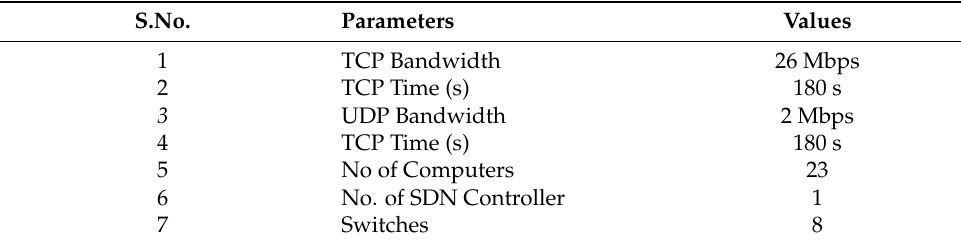
Table 2. Parameters used in Single-controller topology.